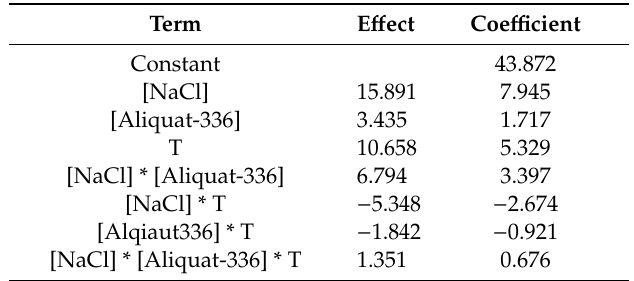
Table 8. Predicted factor regression coe ffi cients and their e ff ect.